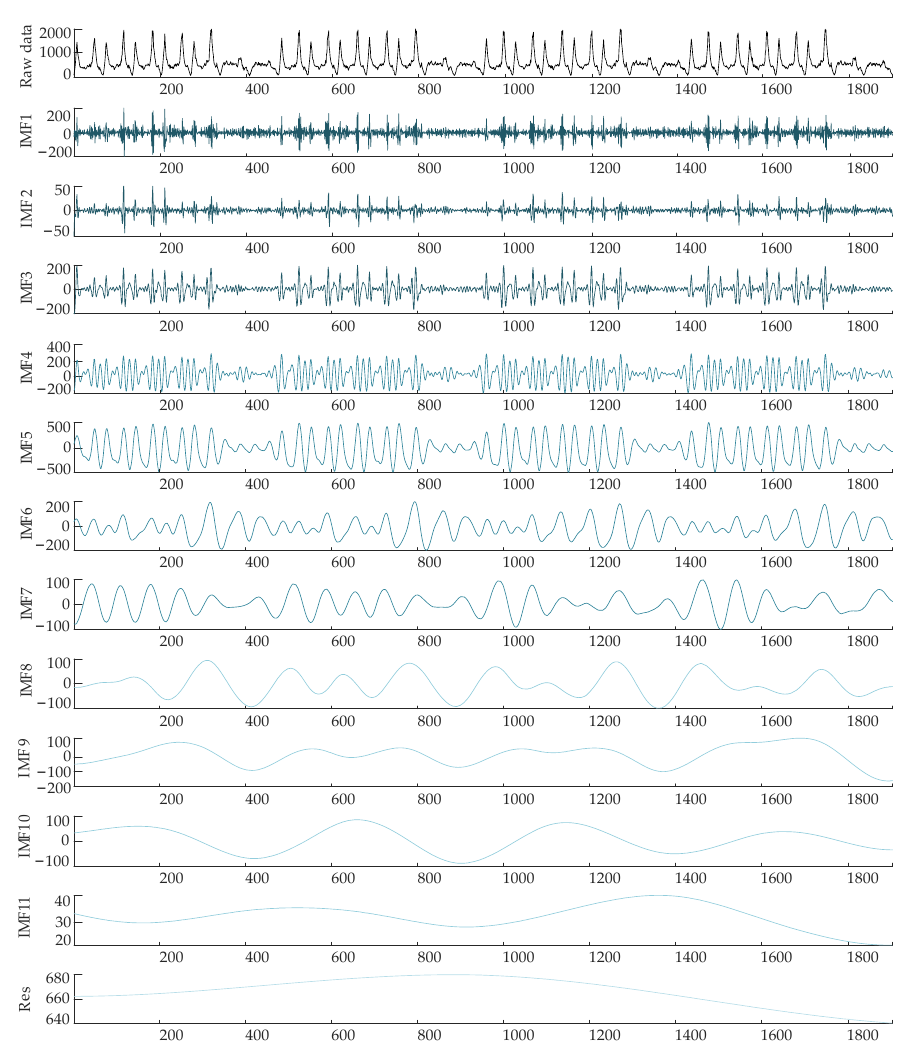
Figure 3. Four weeks of inbound and outbound passenger flow data.